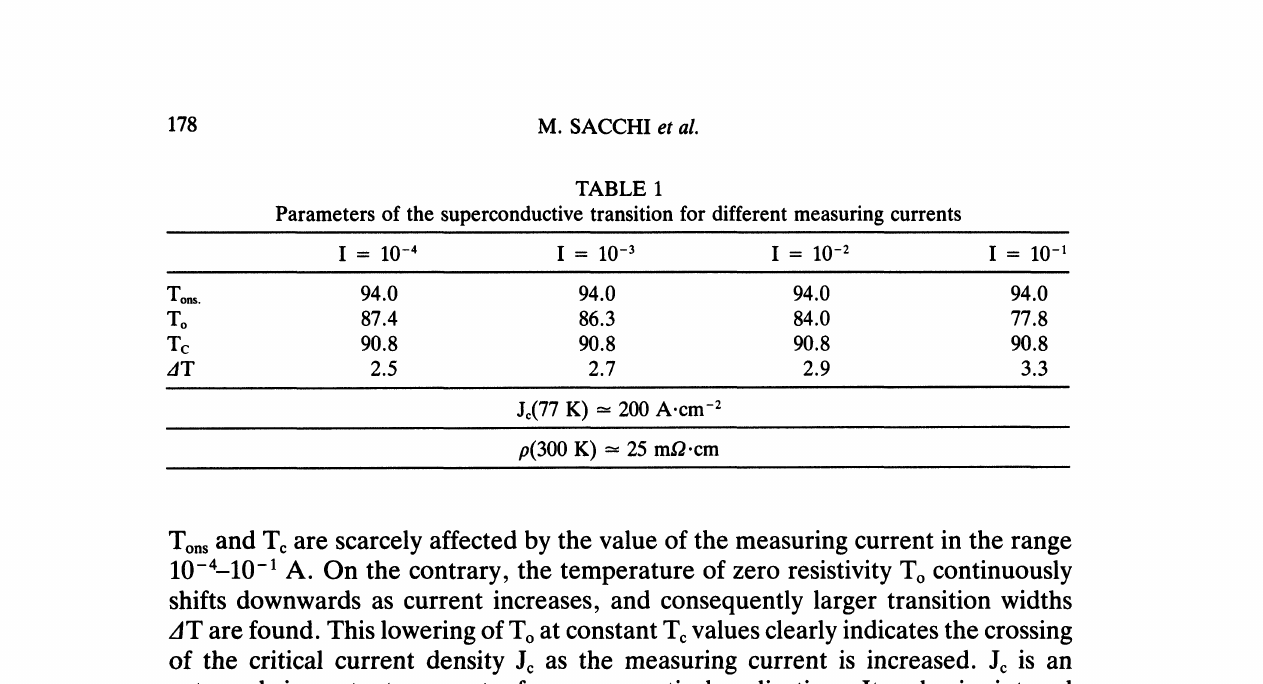
TABLE 1 Parameters of the superconductive transition for different measuring currents